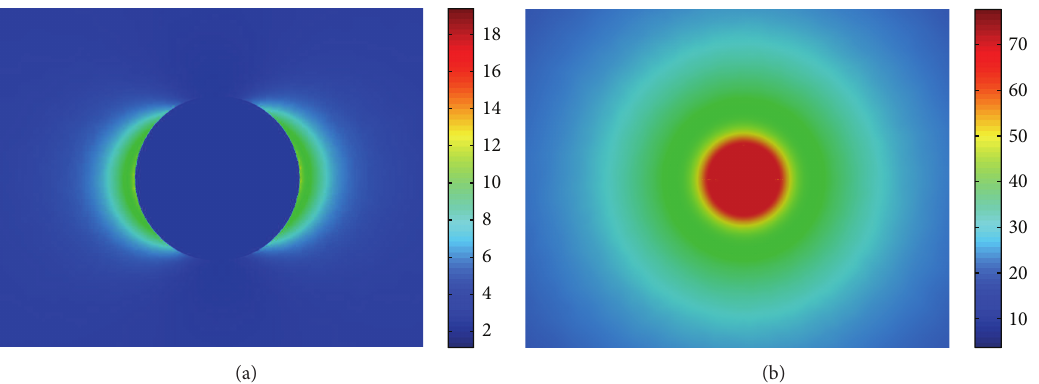
Figure 3: Cut in the median plane 𝑦 = 0 of the distribution of the intensity of the electrical field ‖ E ‖ 2 /‖ E 0 ‖ 2 : (a) of the temperature 𝑇 and (b) after adaption with 𝐴 2 .